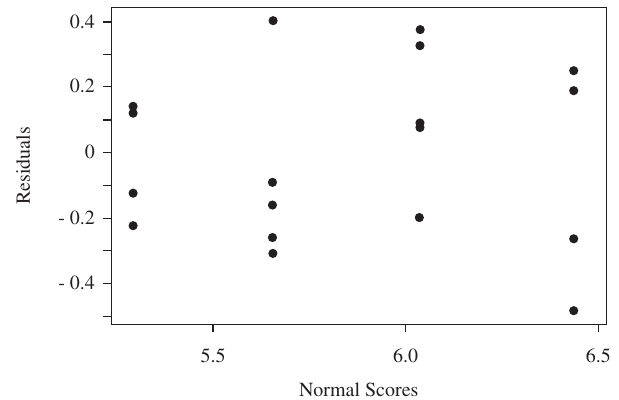
Figure 7. Graph of residuals against estimated values for rolled notch test- pieces (after applying logarithmic scales).